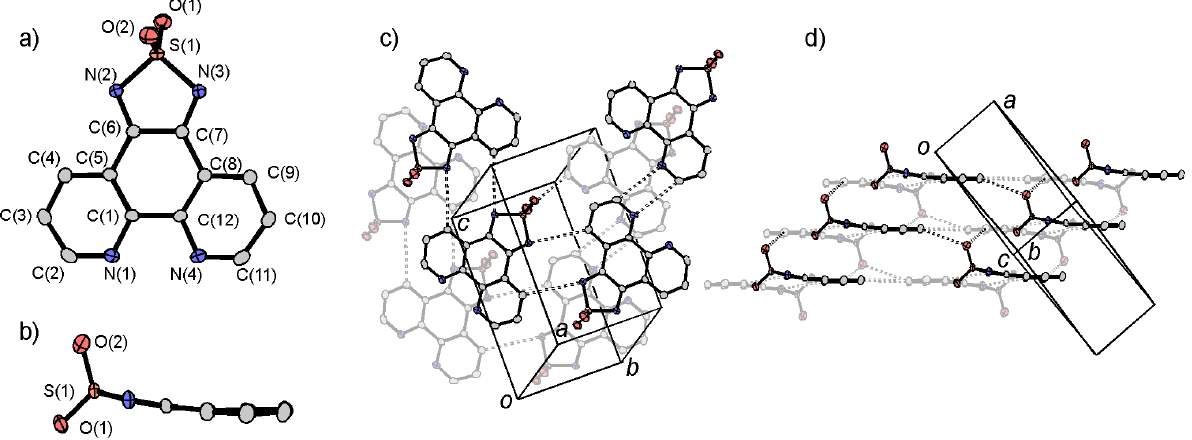
Figure 13. Molecular structure ( a , b ) and crystal structure ( c , d ) of tdapO permission from [47]. Copyright 2011 American Chemical